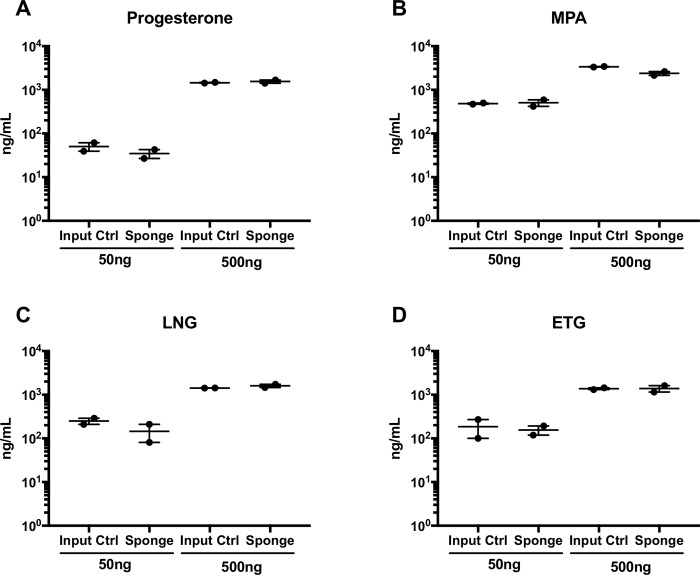
Progestins in cervical mucus can be efficiently retrieved from ophthalmic sponges.Fifty and 500 ng of progesterone and progestins were spiked onto ophthalmic sponges and eluted with 100% methanol. Progesterone (A) and progestin (B-D) values were measured via LC-MS/MS methodologies. Data are representative of 2 independent experiments. Student t tests were performed to compare input control levels to levels eluted from ophthalmic sponges. No statistically significant differences were noted between any groups.